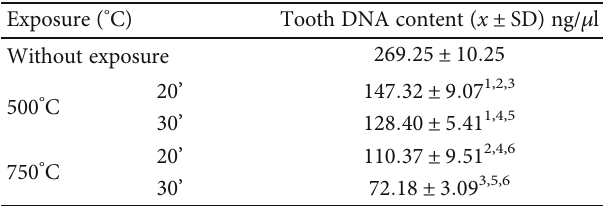
Table 2: Average DNA content of the tooth